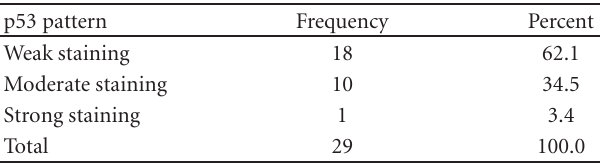
Figure 4: Showing low nuclear staining of p53 in pleomorphic salivary adenoma. Original magnification x40. Table 7: p53 expression of the nucleus staining in myxochondroid (tumor area).